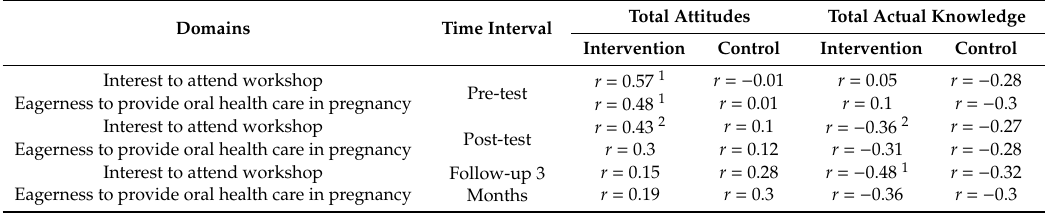
Table 3. Correlation among total attitudes and actual knowledge of midwifery students in the study and their interest and eagerness to attend workshop and provide oral health care in pregnancy. Total Attitudes Total Actual Knowledge Domains Time Interval Intervention Control Intervention